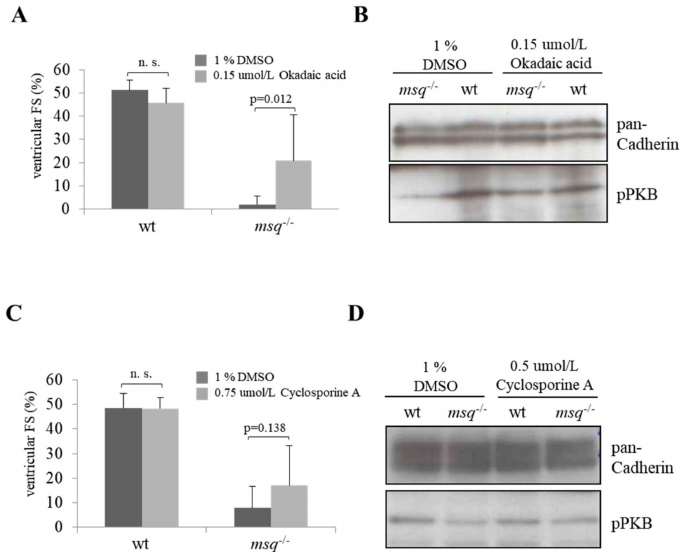
Figure 5. Okadaic acid and cyclosporine A partially reconstitute the contractile force and PKB phosphorylation in msq . ( A ) After treatment with 0.15 µ mol/L okadaic acid during 4–96 hpf homozygous msq − / − embryos showed an increased contractility from 2.0 ± 3.5% to 20.8 ± 19.9%. ( B ) Immunoblotting indicated that the phosphorylation status of PKB (pPKB) was also slightly increased in 0.15 µ mol/L okadaic acid treated msq − / − embryos (incubation during 4–96 hpf). ( C ) Ventricular fractional shortening of msq − / − embryos treated with 0.75 µ mol/L cyclosporine A during 4–96 hpf showed in comparison to DMSO-treated msq − / − embryos (7.9 ± 8.7%) a partially reconstituted contractile force (16.9 ± 16.2%). ( D ) Correspondingly to fractional shortening, immunoblotting revealed that treatment with 0.5 µ mol/L cyclosporine A (incubation during 48–72 hpf) slightly increased the level of phosphorylated PKB in msq − / − embryos compared to controls. (n.s.: Not